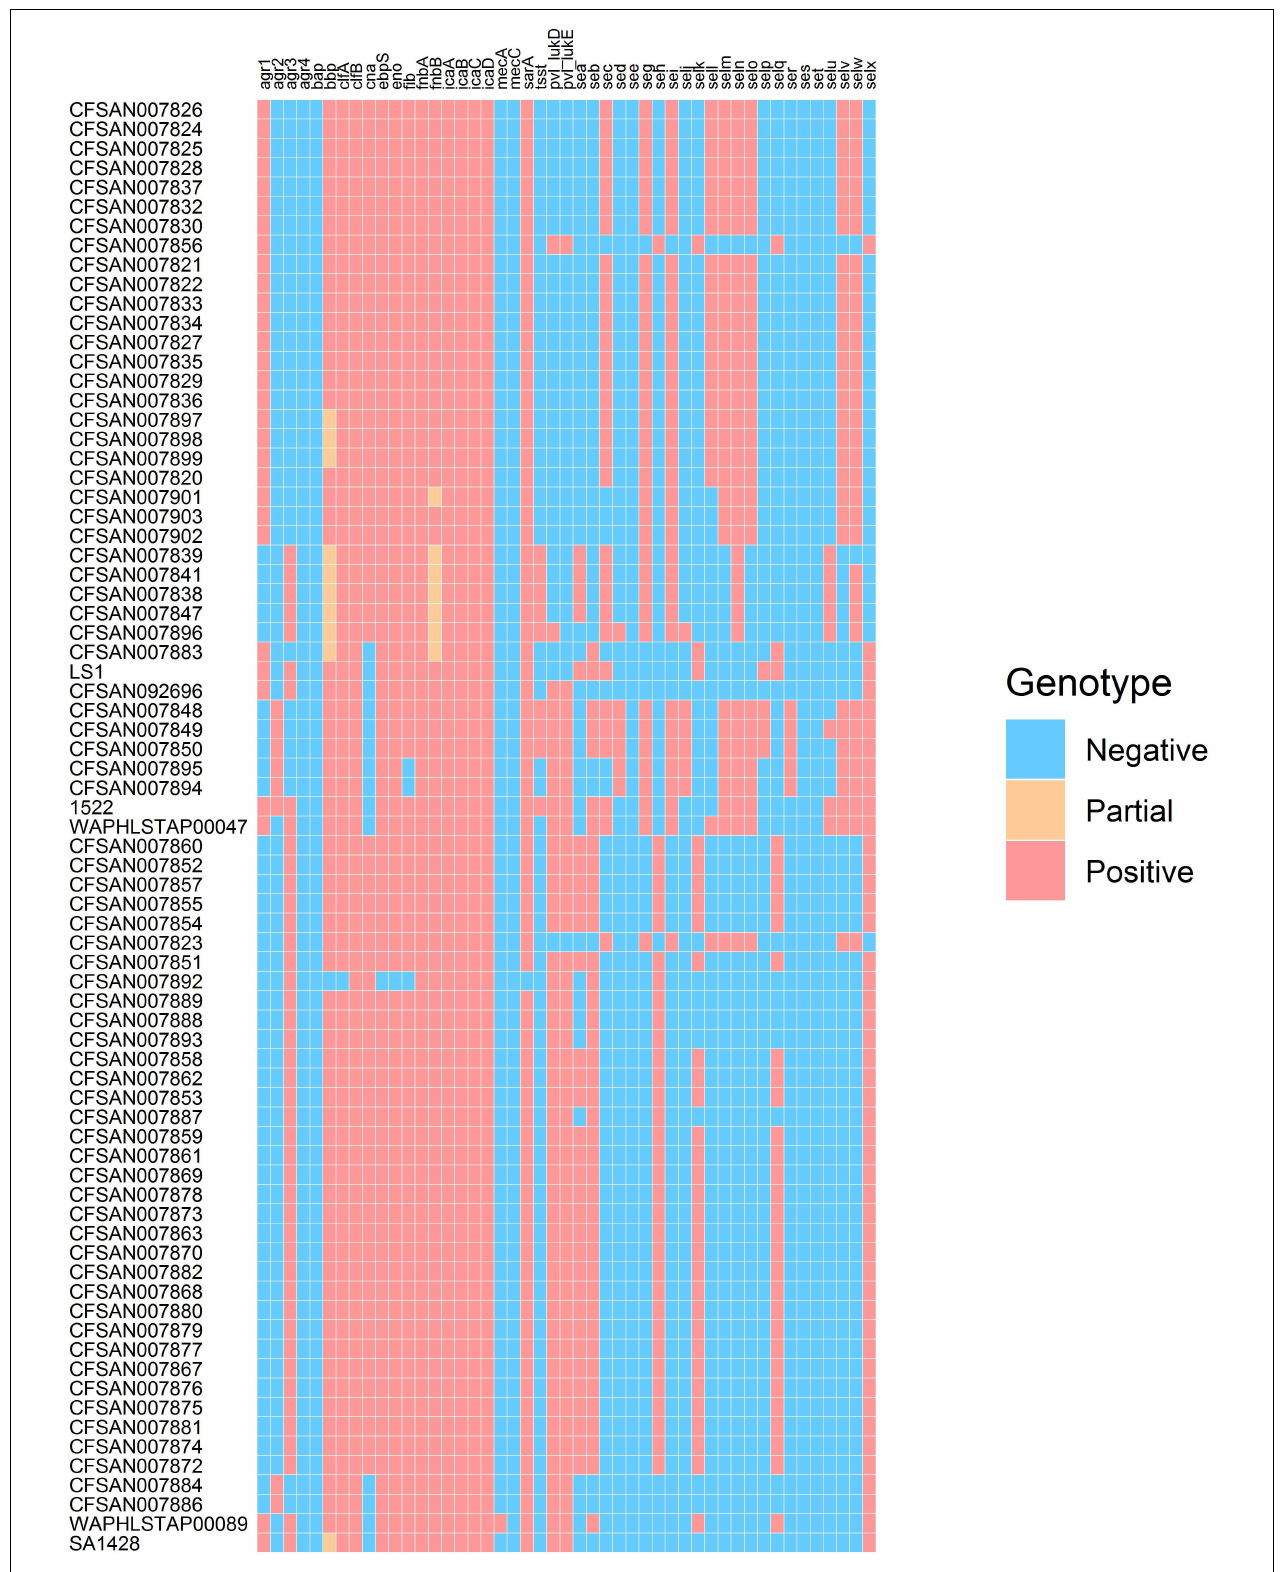
FIGURE 1 | Heatmap illustrating genotype of outbreak-related S. aureus isolates.